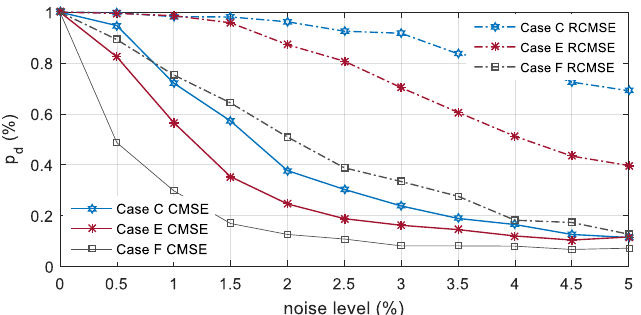
Figure 18. Identification probability of damage cases C, E, and F against the level of noise.